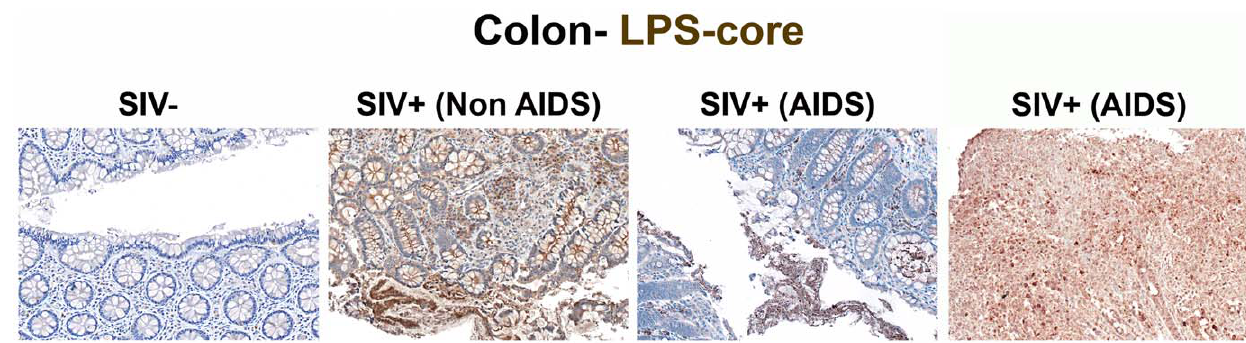
Figure 1. Identification of microbial translocation in large bowel of chronically SIV + RMs. Representative images (200 6 ) of unselected colon sections from SIV-uninfected and chronically SIV-infected RMs (Non-AIDS and AIDS) stained for LPS-core antigen (brown). The images show the array of microbial translocation and damage seen in our cohort that ranged from negligible (SIV- RMs) to regions of epithelial loss in our SIV + Non- AIDS RMs resulting in luminal content in direct contact with the LP and increased frequency of LPS + cells within the LP to more extensive epithelial damage in our SIV + AIDS RMs that extended to overt ulcerations that showed significant microbial product infiltration throughout these regions; features which were absent from our SIV-uninfected RMs. Arrows point to regions of epithelial discontinuities and microbial translocation into the